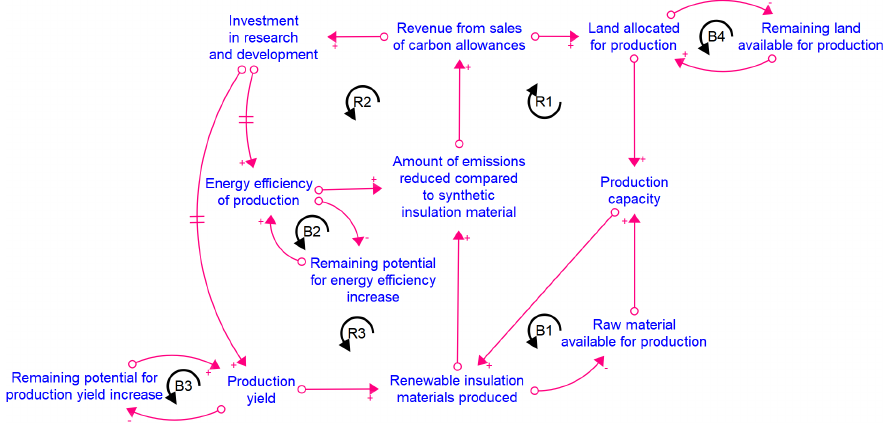
Fig. 2. Causal loop diagram portraying structure of the system dynamics model for mycelium insulation material